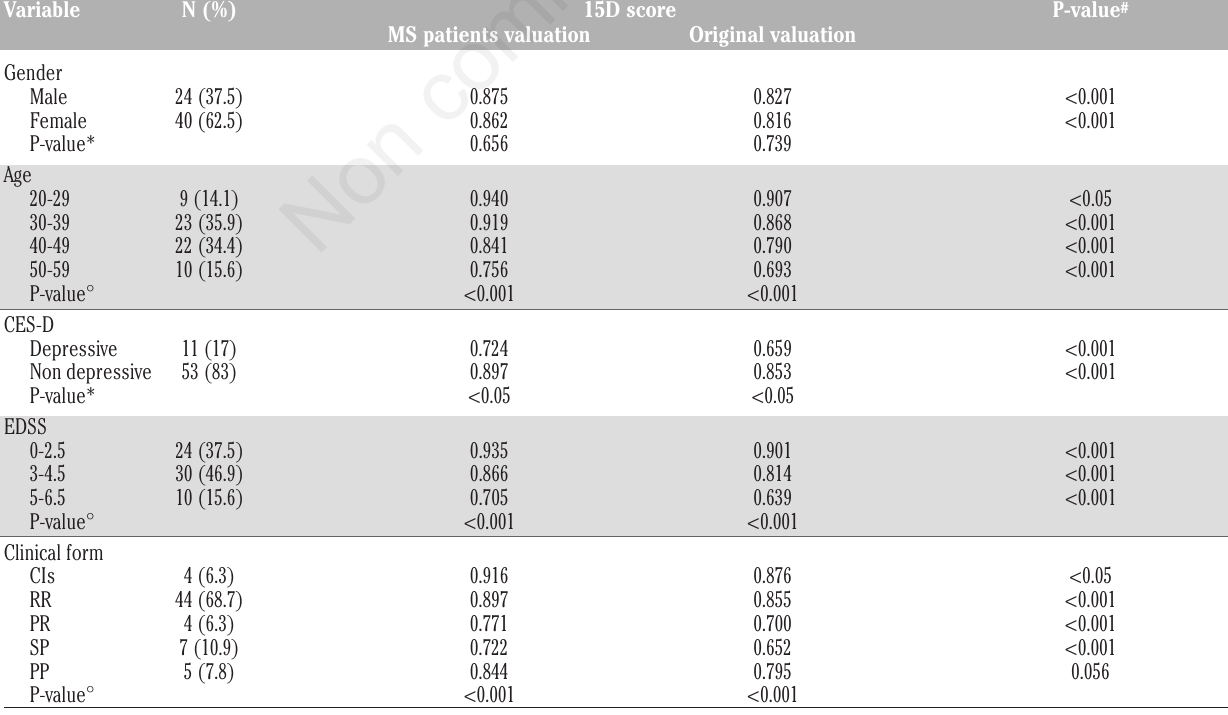
*Mean 15D scores by sex, CES-D compared with t-tests. °Mean 15D scores by age, EDSS and clinical form compared with ANOVA. # Mean 15D scores from MS patients and original valuation compared with paired samples t-tests. MS, Multiple Sclerosis; EDSS, expanded disability status scale; CIs, confidence